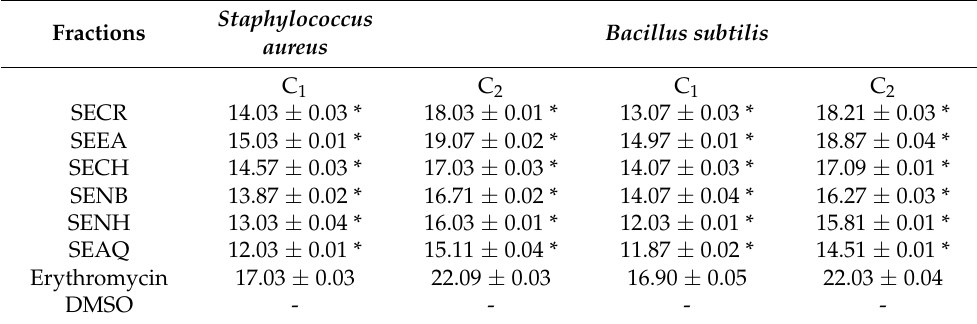
Antibacterial activities of extract and fractions against Gram-positive bacterial